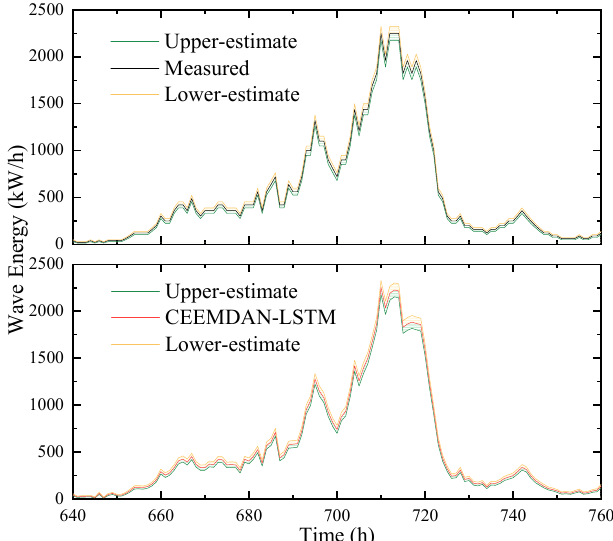
Figure 16. Wave energy estimate results of upper-estimate (green) and lower-estimate (yellow) of CEEMDAN-LSTM prediction (red) in comparison with measured values (black) in 5-s wave period.